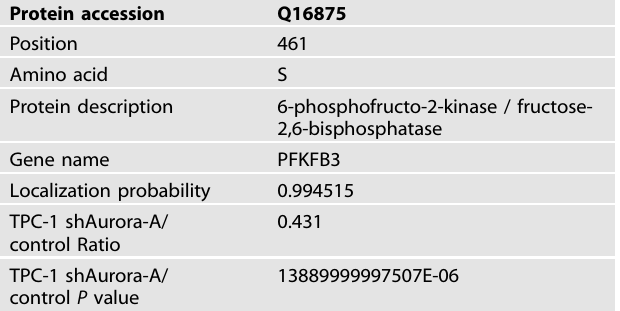
Table 5. PFKFB3 was identi fi ed by phosphoproteome and the phosphorylation level at S461 was signi fi cantly